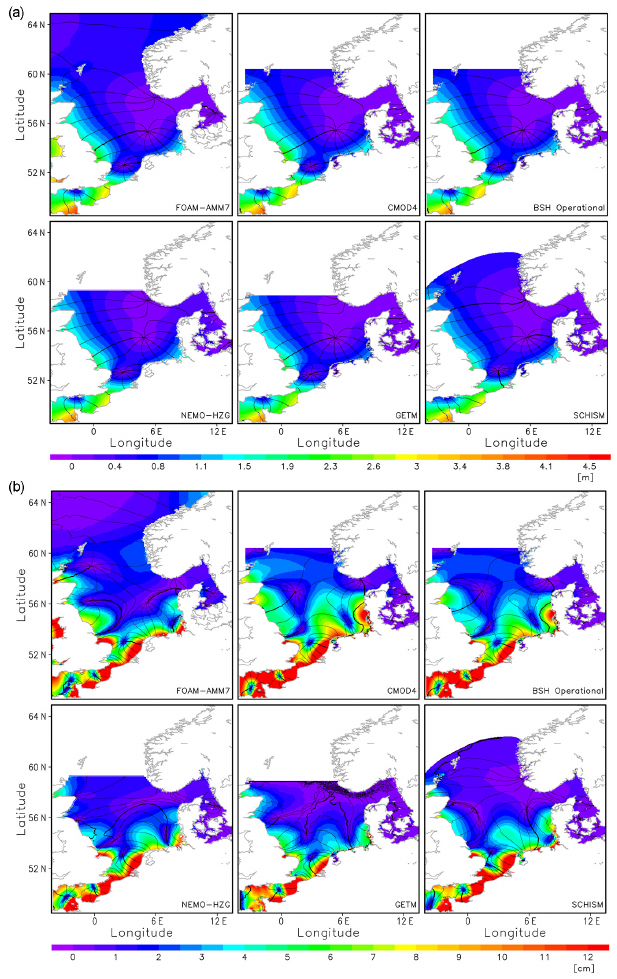
Figure 2. Simulated M2 (a) and M4 (b) tidal amplitudes and phases from six different models operating in the North Sea. The simula- tions using NEMO-HZG, GETM, SCHISM, and BSHcmod are car- ried out at the HZG. Estimates for FOAM-AMM7 and BSHcmod (operational) are derived from the freely available data provided by the marine forecast services (Met-Office) and BSH,